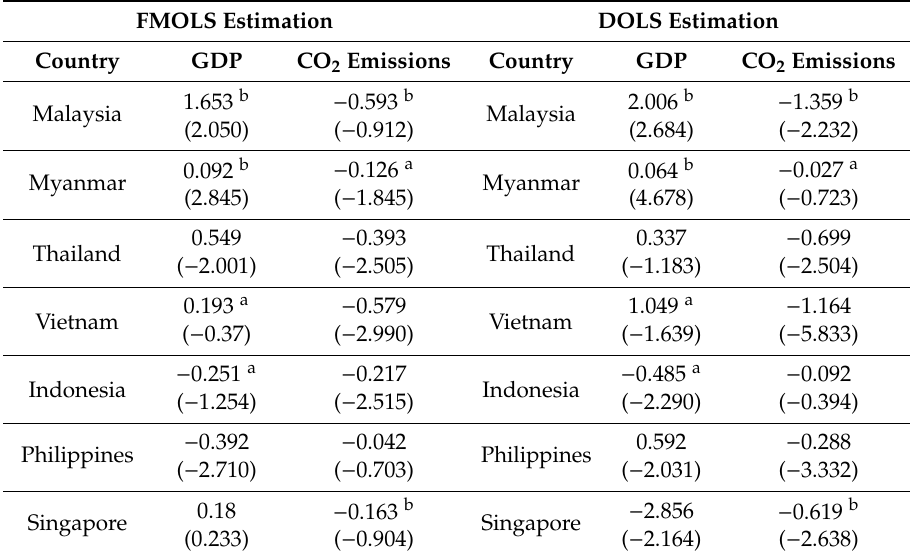
Table 5. Long-run elasticity results (dependent variable: renewable energy